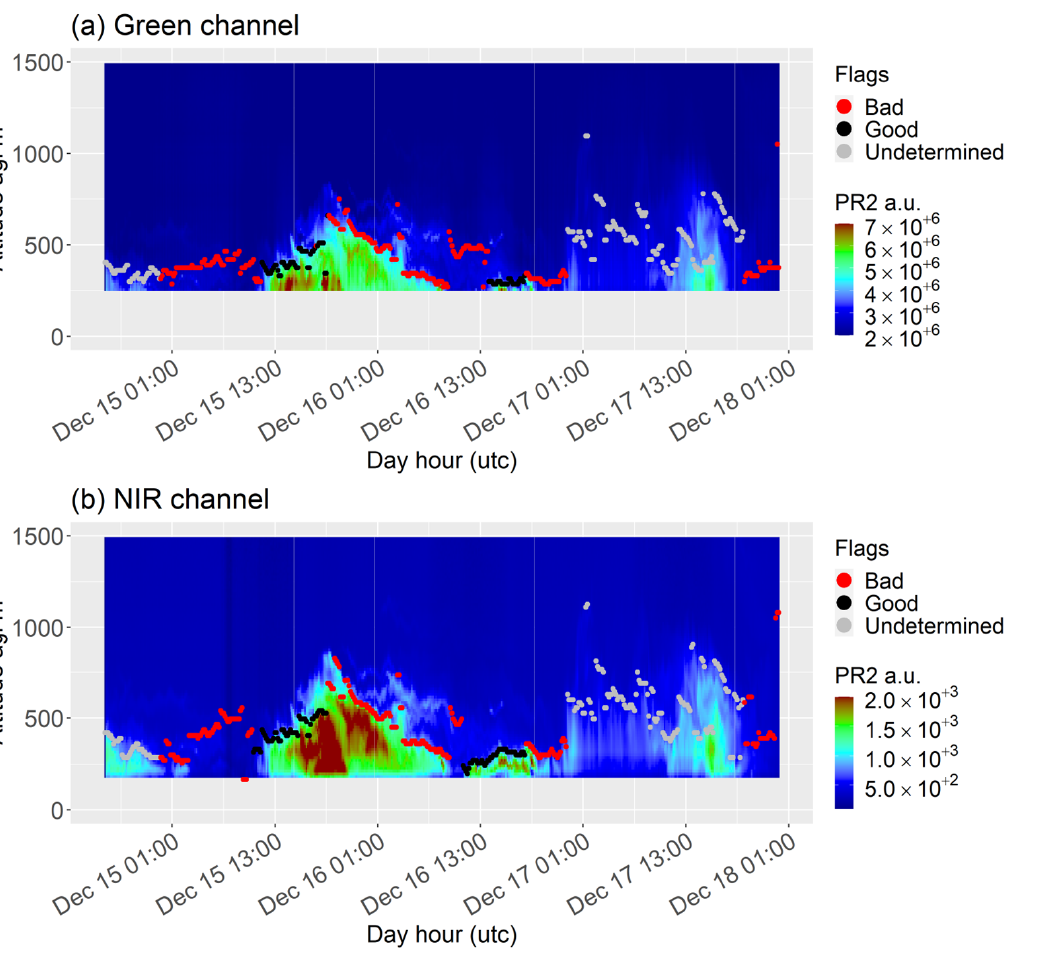
Figure 9. Time series of the PR2 signals inferred from both the green ( a ) and the near ‐ infrared channels (NIR, ( b )) during the WB event. The black dots represent the ABLH applying the Haar wavelet method on the green and near ‐ infrared datasets.